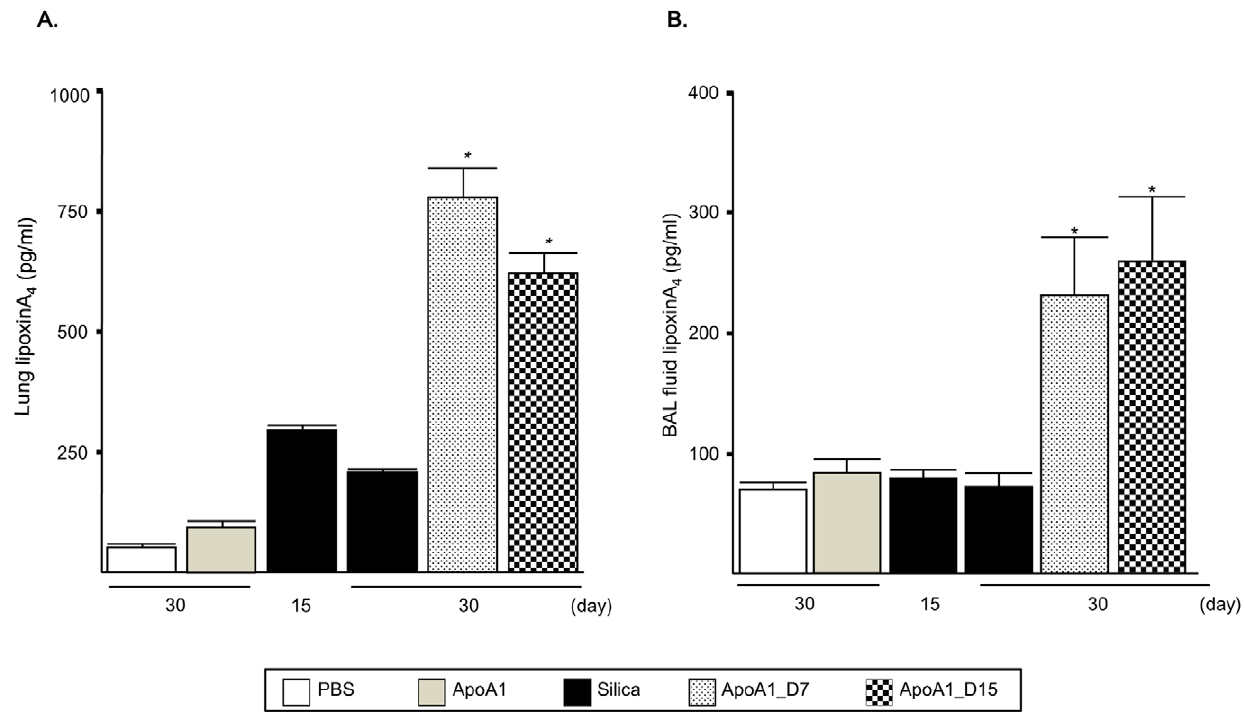
Figure 5. Quantification of LXA4 levels in the lung parenchyma(A) and BAL fluid(B) of the ApoA1 transgenic mice. * p , 0.05 compared with the Silica group (D30).